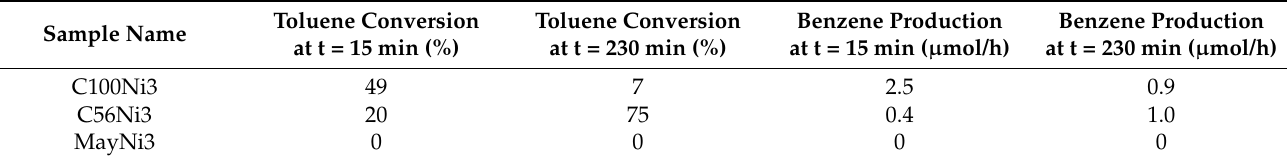
Table 8. Toluene conversion of impregnated bi-functional compounds and corresponding benzene production as